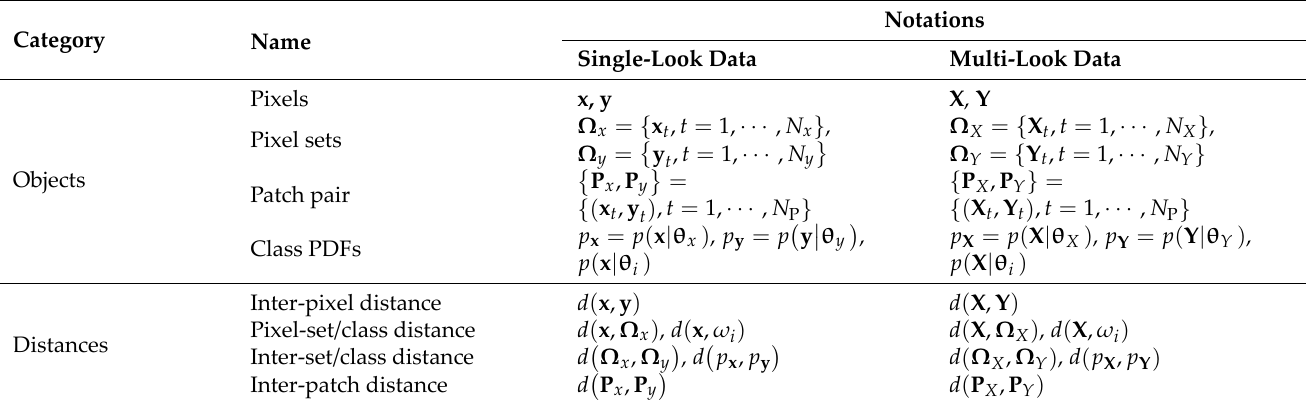
Table 1. Notations of PolSAR image objects and